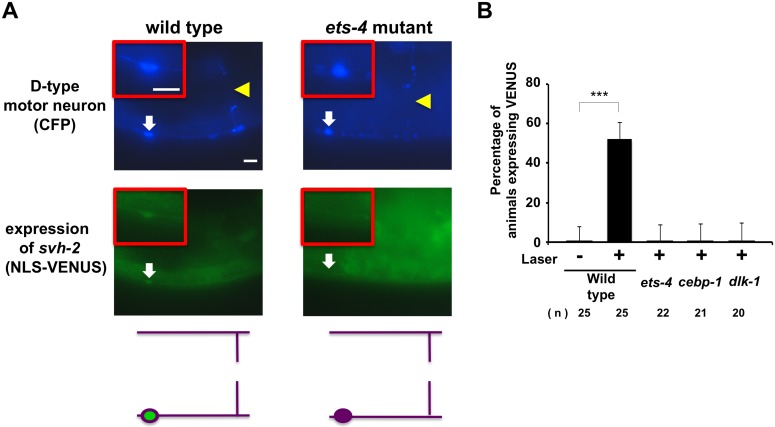
ETS-4 and CEBP-1 are required for the transcriptional induction of the svh-2 gene in response to axon injury.(A) Induction of Psvh-2::nls::venus expression in D-type motor neurons by laser surgery. Expression of fluorescent proteins in D-type motor neurons of wild-type and ets-4 mutants 3 hr after laser surgery are shown. Yellow arrowheads and white arrows indicate axon and cell bodies, respectively, of D-type neurons after laser surgery. D neurons are visualized by CFP under control of the unc-25 promoter. Cell bodies of D-type neurons are magnified and shown within the upper boxes. A schematic representation of D-type motor neurons is shown below. Scale bars = 10 μm. (B) Percentages of animals expressing svh-2. Induction of Psvh-2::nls::venus expression in D-type motor neurons with (+) or without (-) laser surgery was assayed as described in Materials and Methods. The numbers (n) of animals examined are shown. Error bars indicate 95% SI. ***P<0.001.